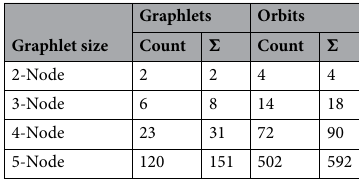
Table 1. Number of pn-graphlets and